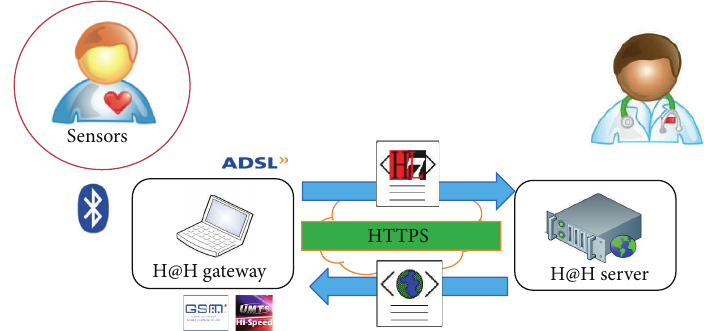
Figure 1: H@H system architecture.